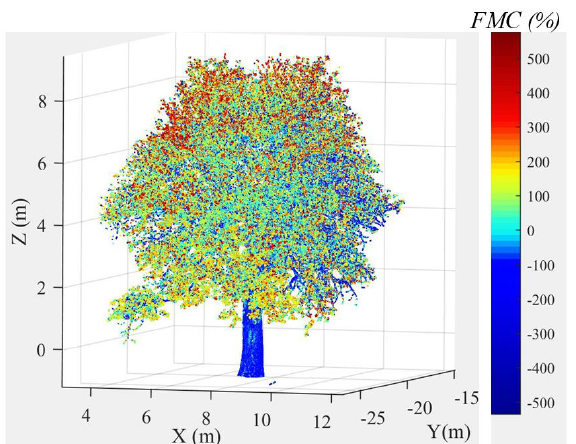
Figure 3. 3D FMC point cloud of Swedish Whitebeam tree 1, showing a heterogeneity in FMC distribution within canopy, and difference between FMC of foliage and